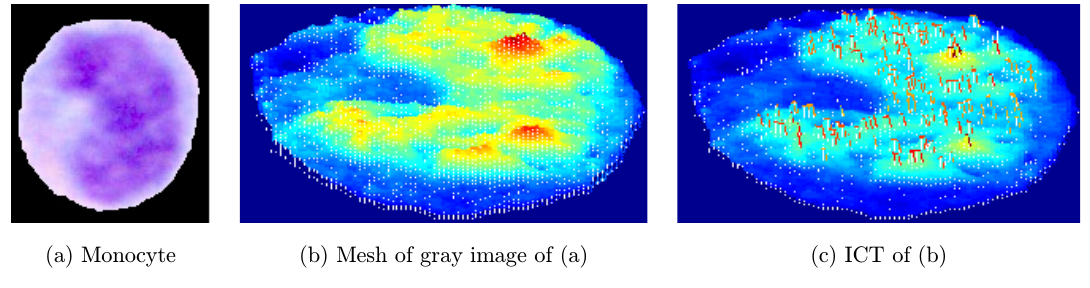
Fig. 8. Clustering of